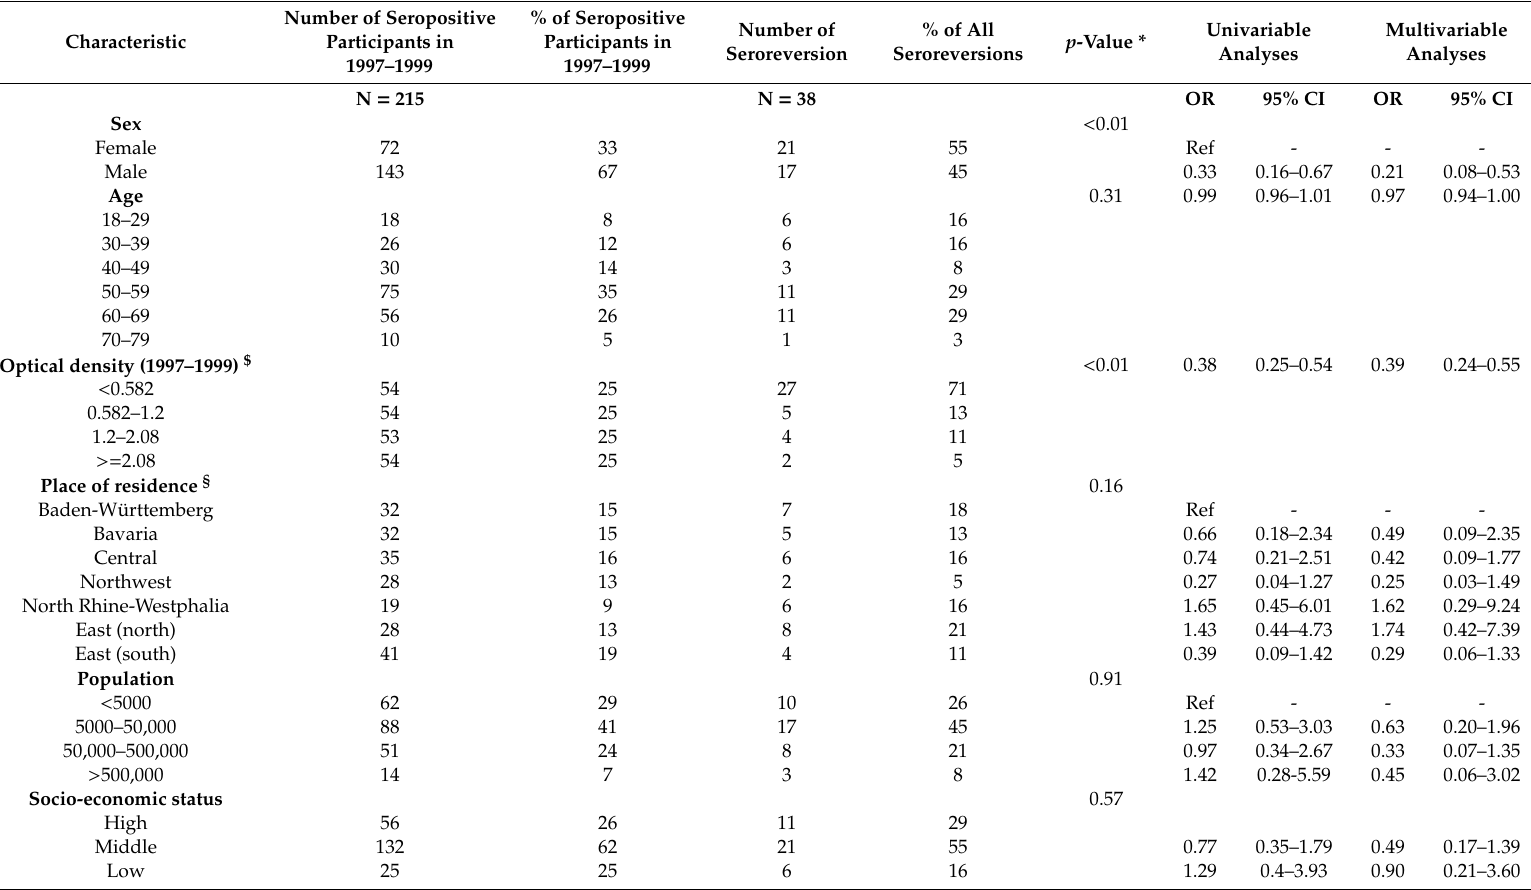
Table 2. Predictors of seroreversion of Borrelia burgdorferi -specific antibodies among participants of two population-based serosurveys in Germany, in 1997–1999 and